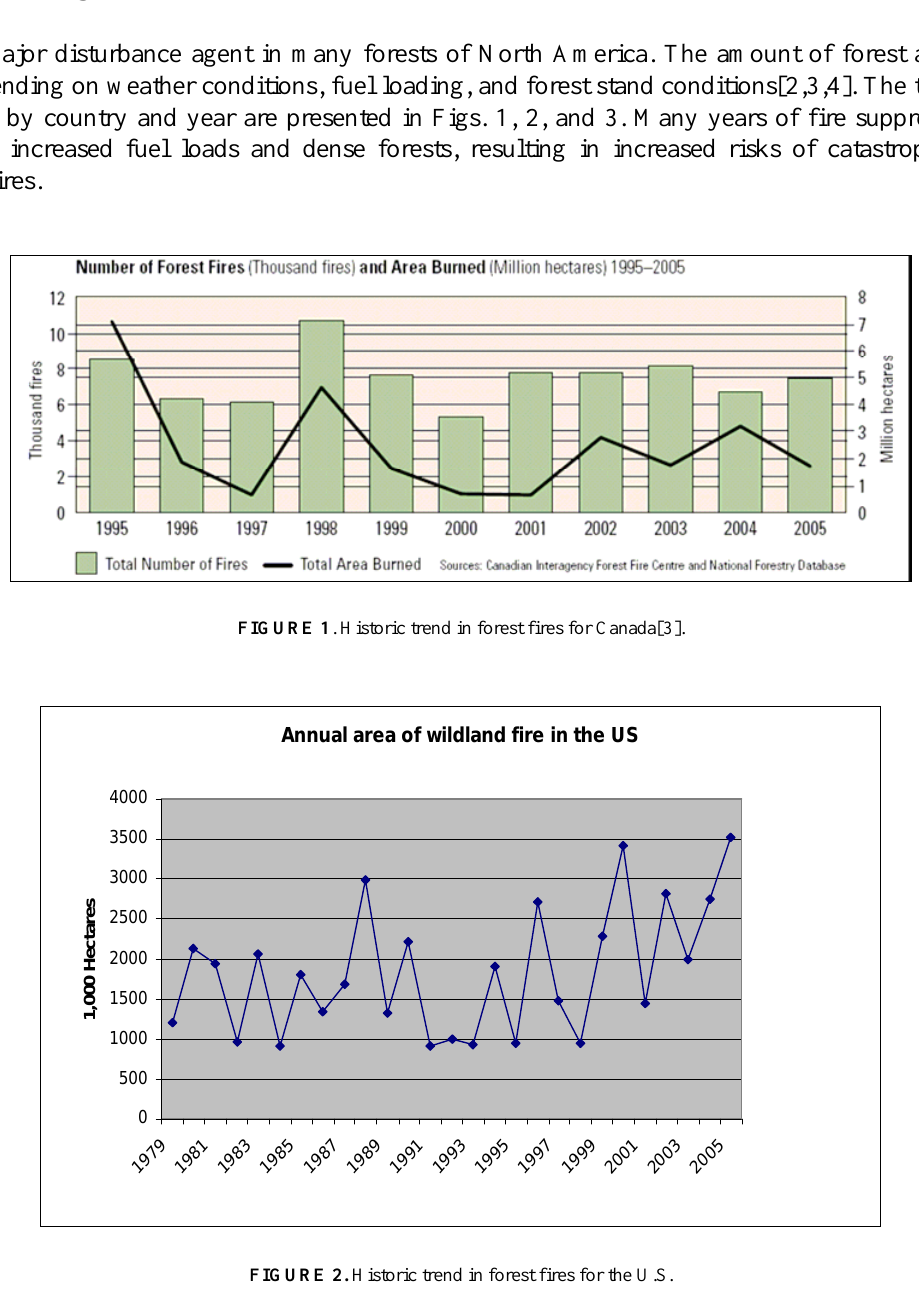
FIGURE 2. Historic trend in forest fires for the